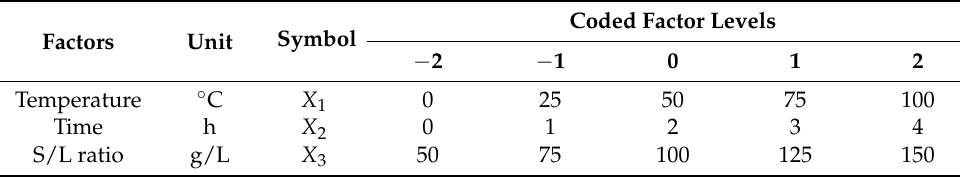
Table 1. Factors and their levels for the central composite design